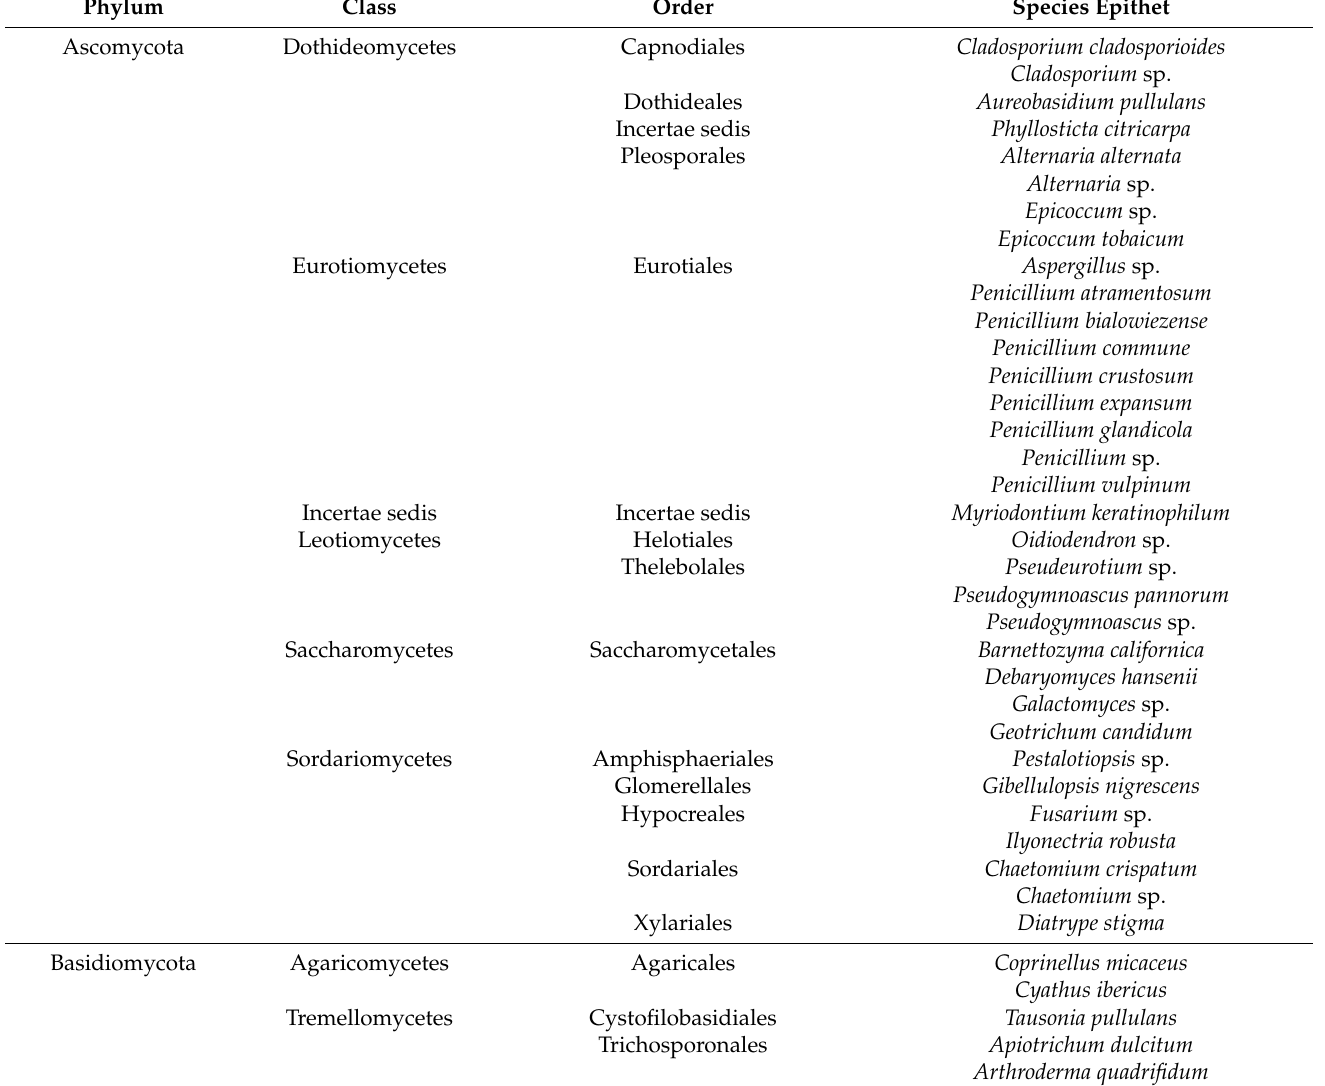
Table 2. Presumptive species list for isolates which could be identified to a single